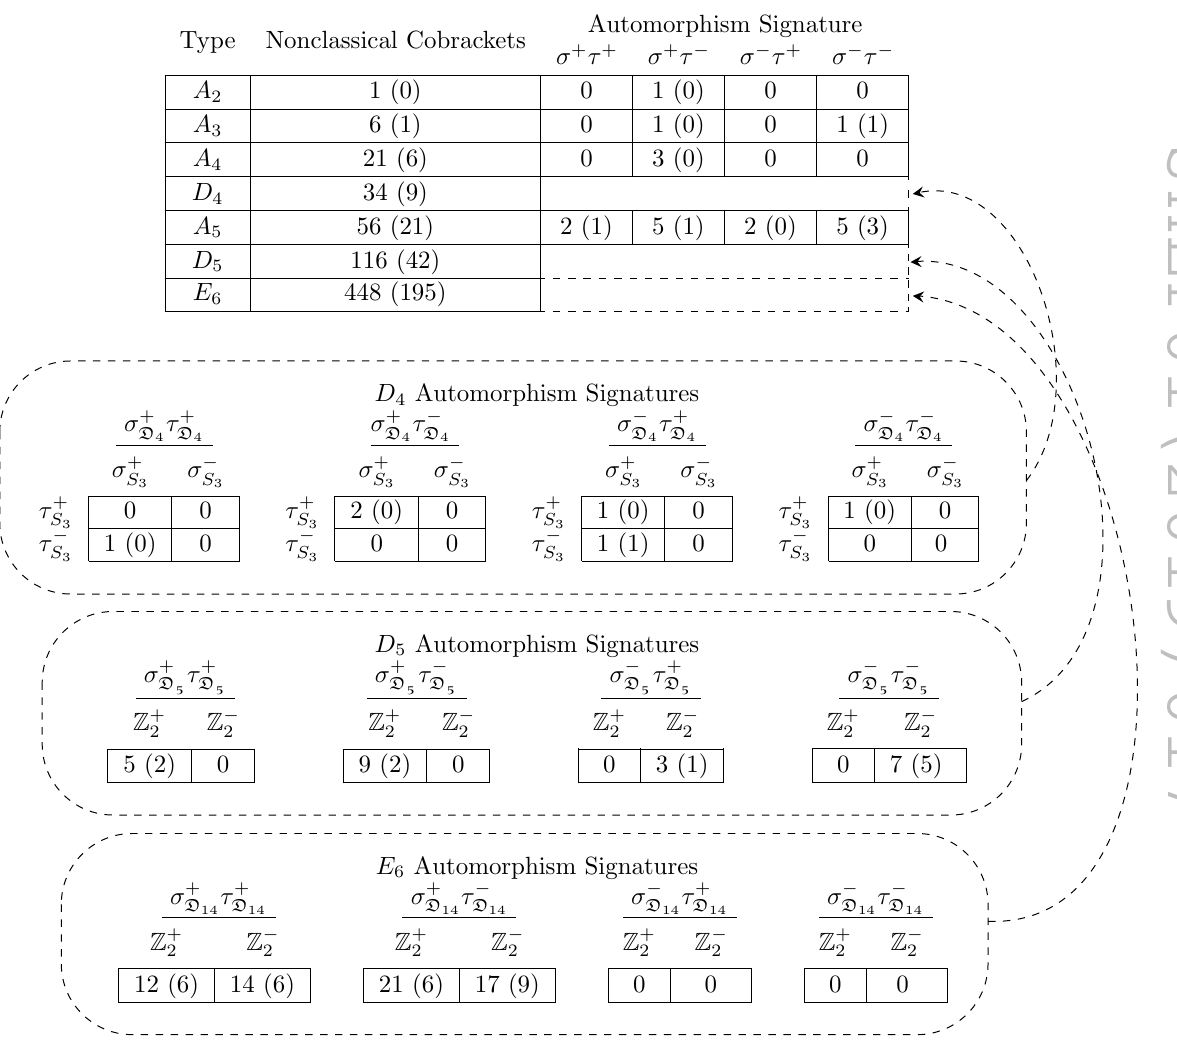
Table 5. The number of nonclassical weight-four cluster polylogarithms on various (cid:12)nite cluster algebras, prior to consideration of their automorphism group and after requiring speci(cid:12)c automor- phism signatures. The number of polylogarithms that can also be made to satisfy cobracket-level cluster adjacency is given in